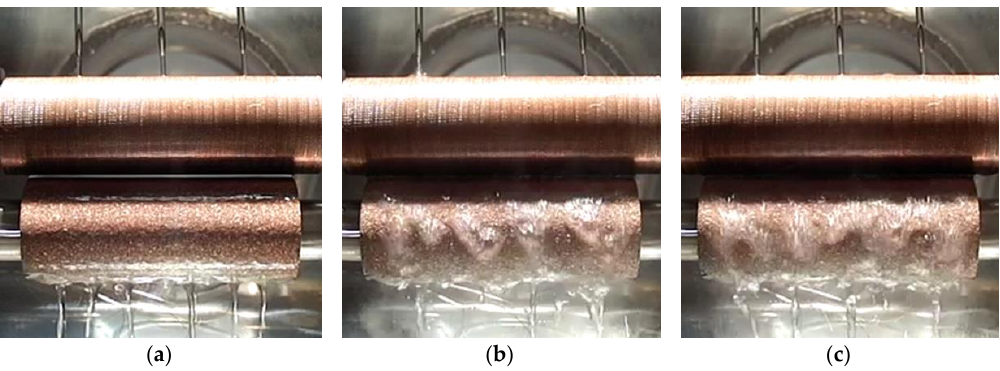
Figure 6. Falling film evaporation behaviors on the thermal spray coated tube. ( a ) Re f = 323 without heating. ( b ) Re f = 430, q = 33.4 kW·m −2 . ( c ) Re f = 643, q = 33.4 kW·m −2 .